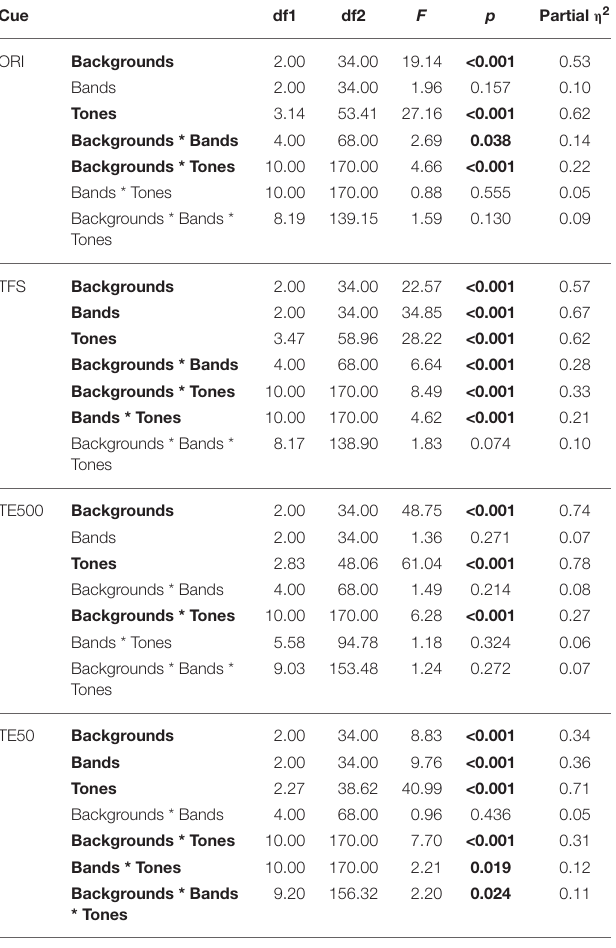
TABLE 10 | Results of Backgrounds * Bands two-way repeated measures ANOVA on tone accuracy by Tones when Cue = TE50. Cue Tone df1